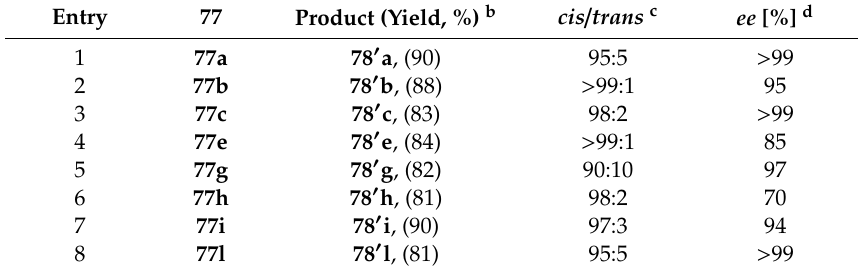
Table 2. Synthesis of cis -(1 S ,2 S ,3 S )-trisubstituted cyclopropanes 78 (cid:48) from endo -camphor selenonium ylide 76 .